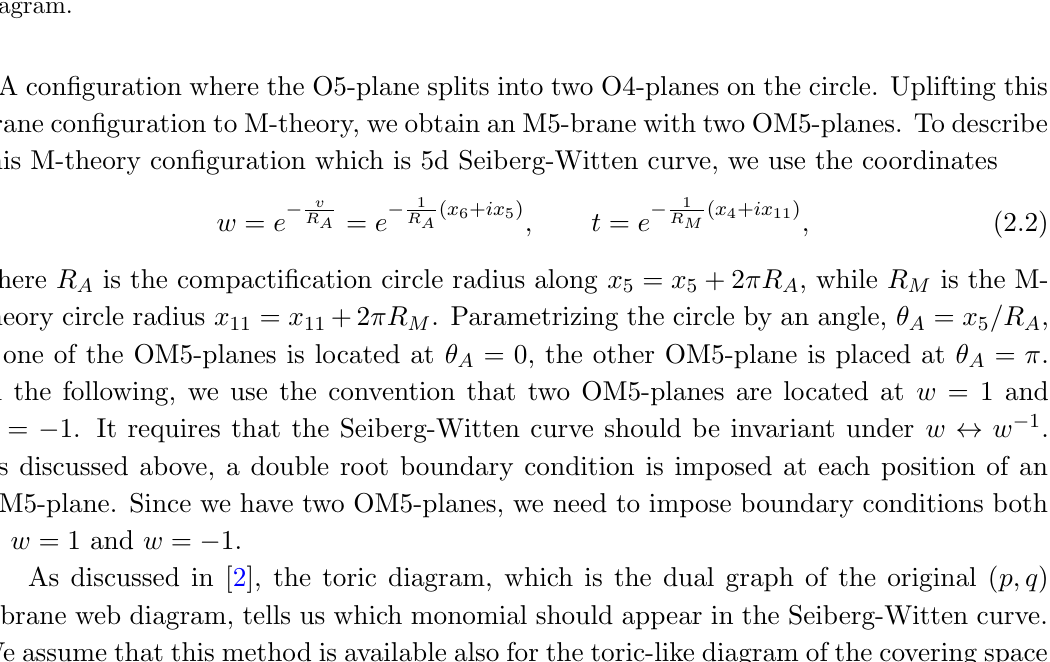
Figure 2. Covering space web con(cid:12)guration for 5d Sp(1) theory and corresponding toric-like